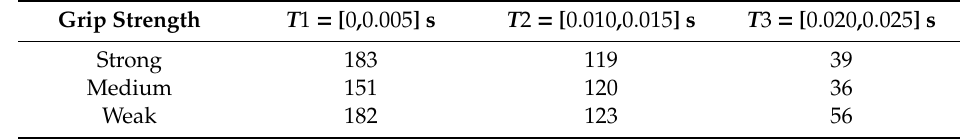
Table 5. Evolution of root mean square (RMS) value (m/s 2 ) after contact.